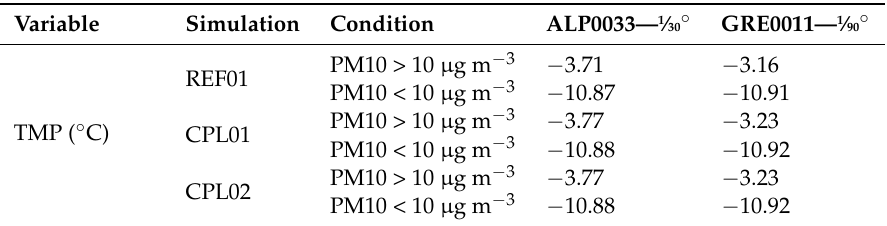
Table 9. Impact of the resolution and the on-line coupling on the average temperature (TMP), the cumulated liquid water content over the domain (LWC) (as computed by Equation (1)) and the vertical diffusion coefficient (KZZ) in 3D on 29 November for the target domain GRE0011. Two conditions for the averaging process based on the threshold of 10 µ g m − 3 are applied on PM10 based on the REF01